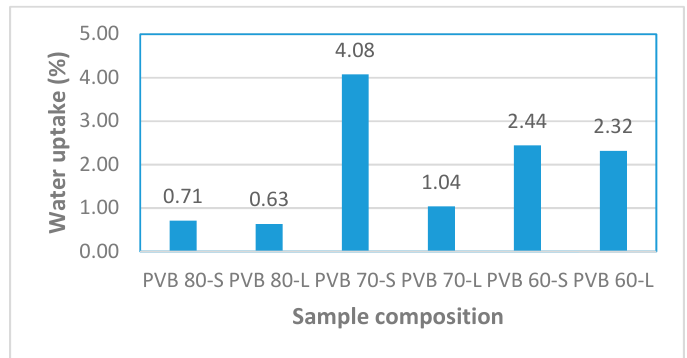
Figure 7. Percentage of water uptake of the composites after 25 days .